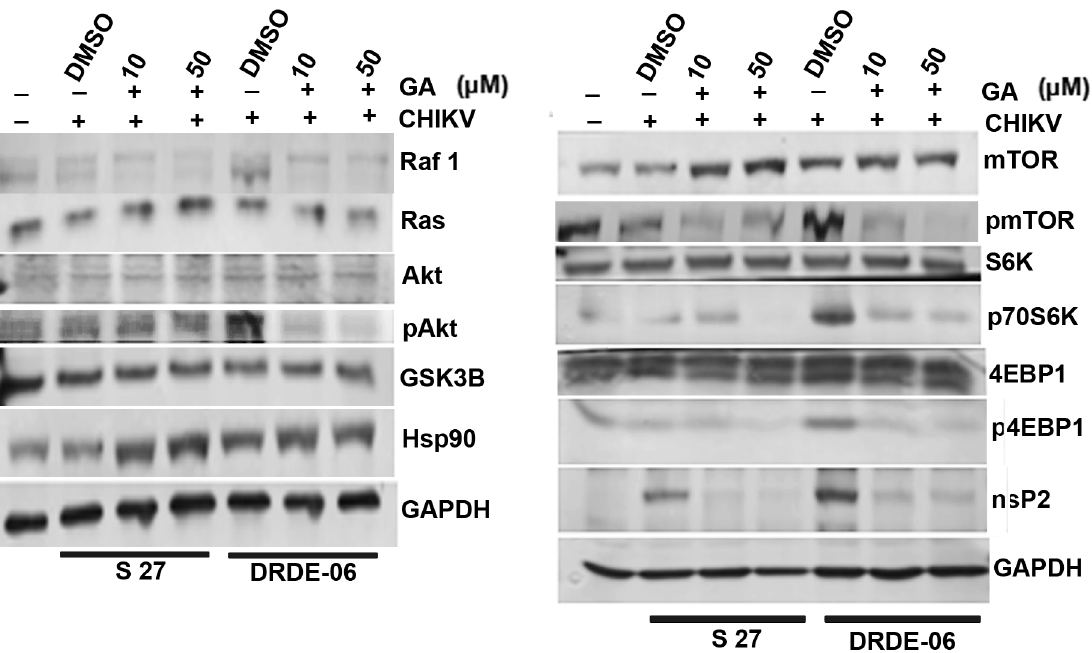
Figure 6. Enhanced activation of Hsp client proteins after CHIKV infection. Vero cells were infected with either S 27 or DRDE-06 with MOI 0.1 and treated with different doses of GA (10 and 50 m M) and the cells were harvested at 8hpi. Western blot was performed using cell lysates and probed with Hsp90, Raf1, Ras, Akt, pAkt, GSK3 b , mTOR, pmTOR, S6K, p70S6K, 4EBP1, p4EBP1 and nsP2 antibodies. GAPDH was used as the loading